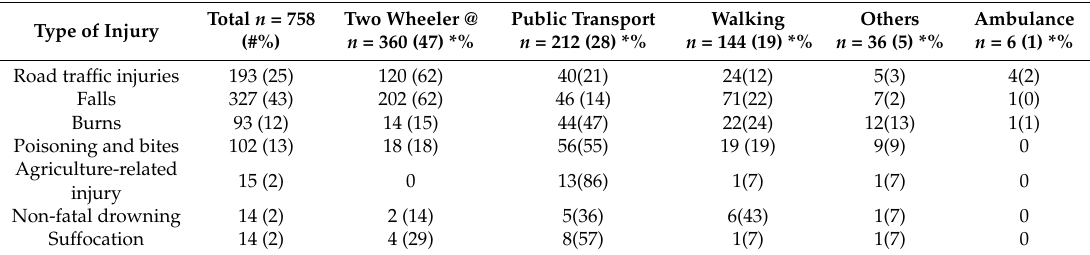
Table 4. Mode of transport for injured children ( n = 758) in different injuries.